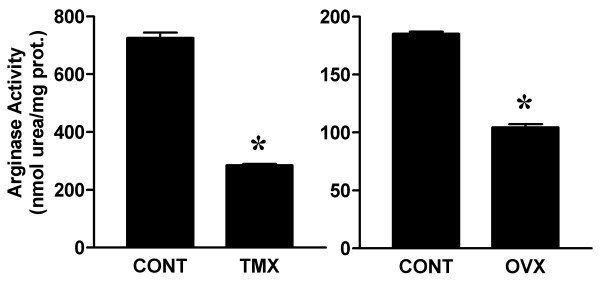
Effect of tamoxifen on vaginal arginase activity. Total arginase enzyme activity was determined in vaginal tissue extracts from control (CONT) and tamoxifen-infused (TMX) rats (see Figure 1). For relative comparison, estradiol binding in vaginal tissue extracts from control and ovariectomized (OVX) rats was determined in separate assays. Data are the mean ± SEM from 3 independent assays. *p < 0.05 versus control group.